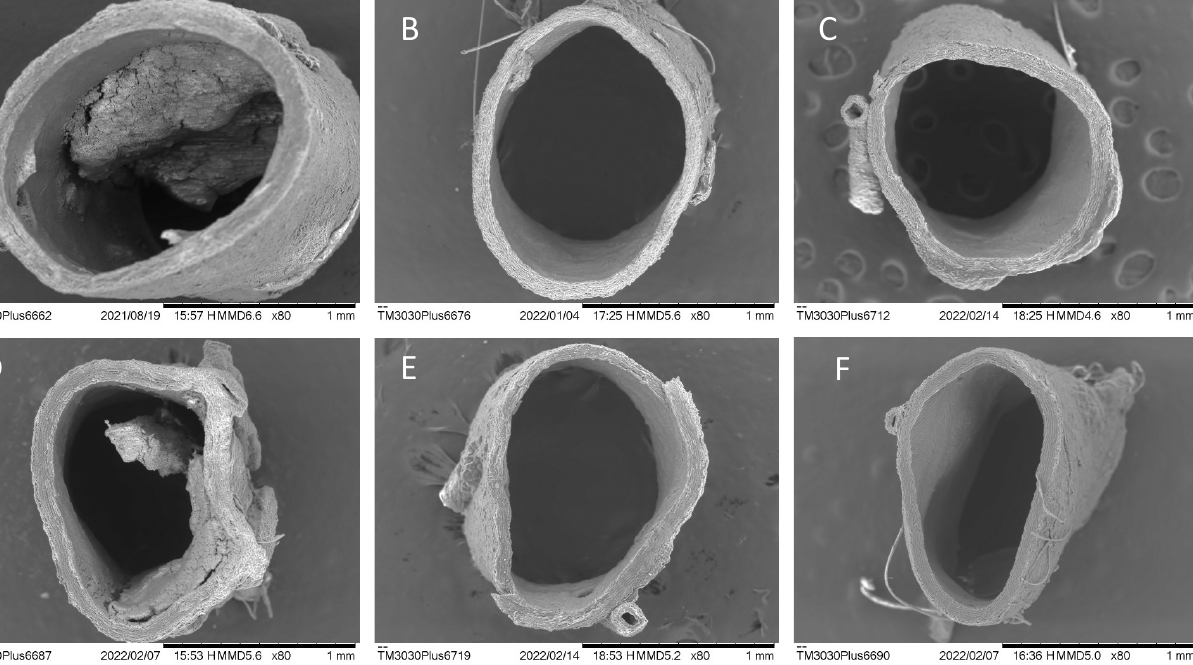
Table 2. Prediction of Activity Spectra for Substances ( PASS), where Pa means the probability of activity and Pi means the probability of inactivity.